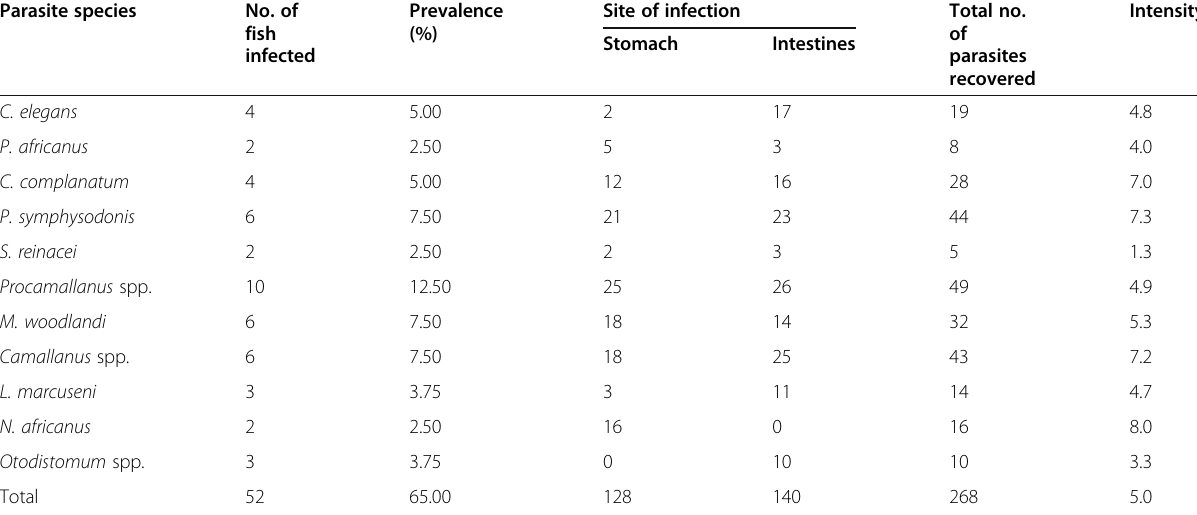
Table 7 Distribution of endoparasites in relation to the site of infection in infected C. gariepinus Parasite species No. of